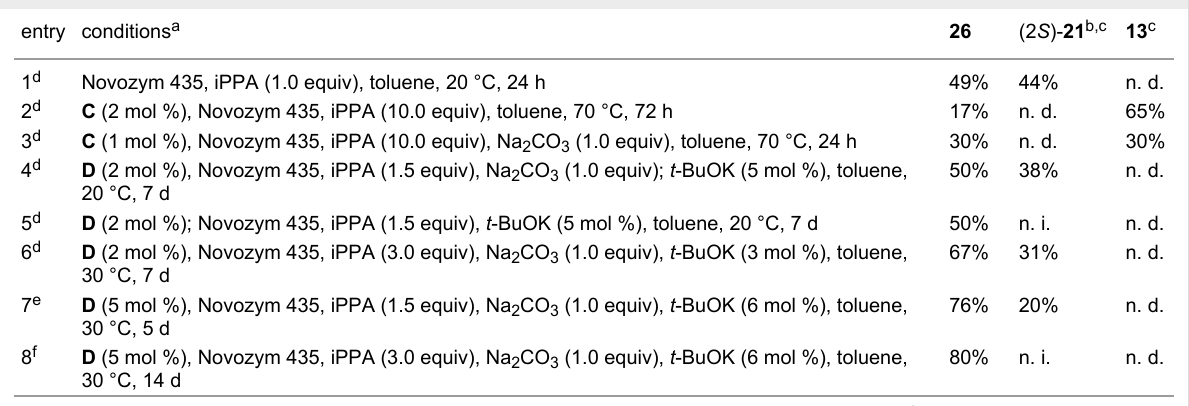
Table 4: Optimization of conditions for Ru–lipase-catalysed DKR of 21 . entry conditions